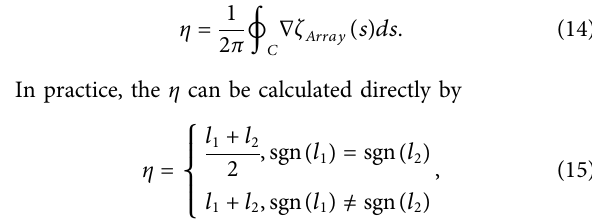
Frontiers in Physics |